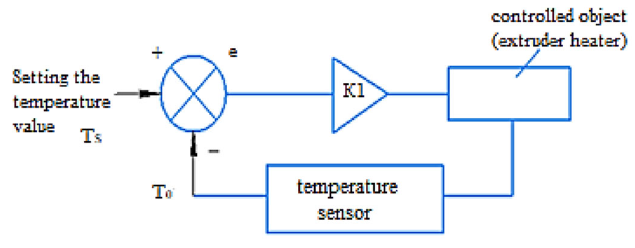
Figure 11. Figure 11. P—regulator.